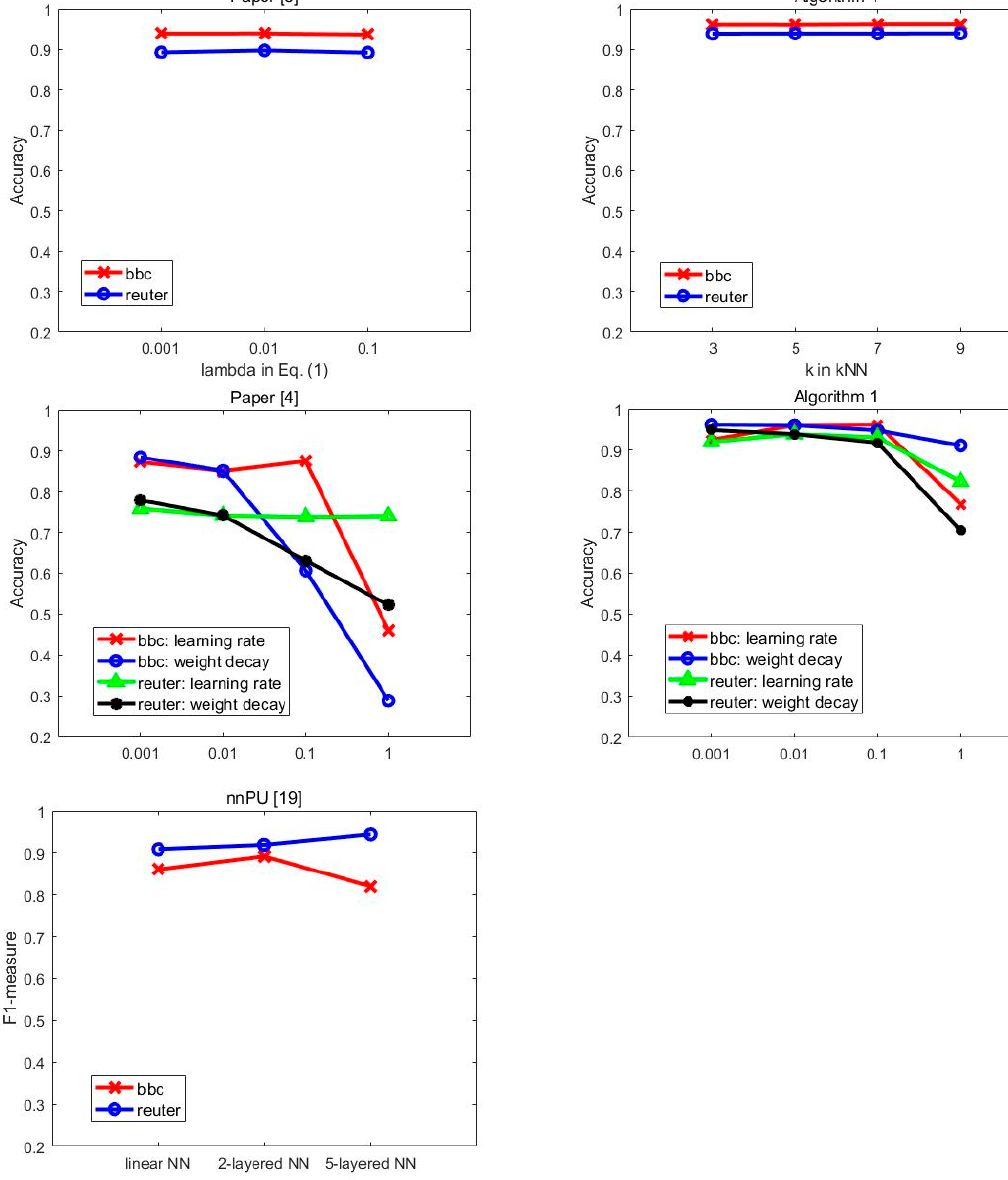
Figure 3. The performance comparison when changing parameter values.